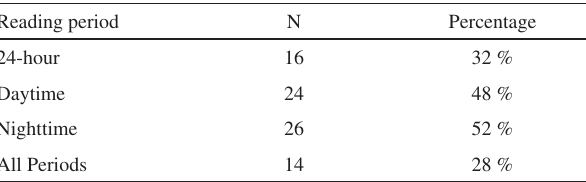
Table 3 - Prevalence of normal ambulatory blood pressure Reading period